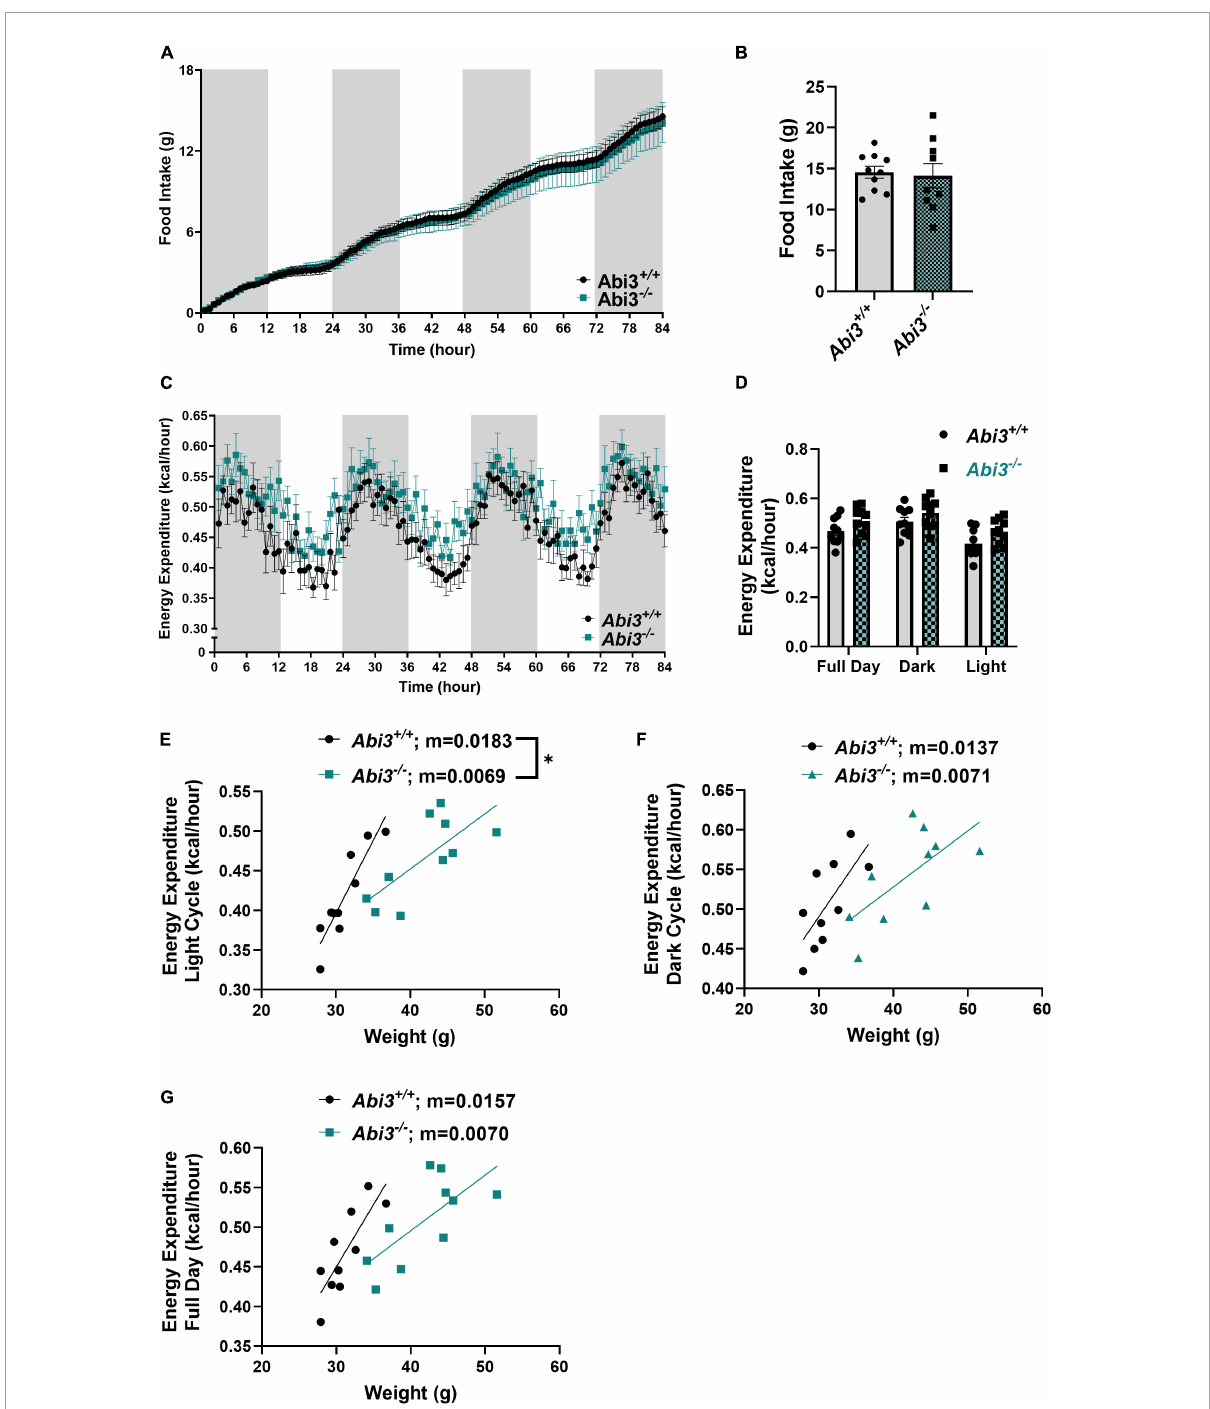
FIGURE2 Abi3 - / - mice exhibit impaired energy expenditure and unaltered food intake. 15-month-old male Abi3 + / + ( n = 10) and Abi3 - / - mice ( n = 10) were singly housed in metabolic cages and (A,B) food intake and (C,D) energy expenditure were recorded over 84 h. For time course graphs (A,C) , the shaded portions represent night hours (dark cycle) and the unshaded portions represent daytime (light cycle). (A) Food intake over time and (B) overall total food intake were recorded. (C) Energy expenditure over time and (D) average energy expenditure were measured. (D) Average energy expenditure was calculated for the daytime/light hours (light cycle), night/dark hours (dark cycle), and the entire 84 h (full day). (E–G) Subsequent linear regression analysis of average energy expenditure vs. weight was performed to assess the relationship between lean mass and energy expenditure. Regressions were performed for (E) light cycle, (F) dark cycle, and (G) full day. Data represent mean ± SEM. Unpaired t -test, simple linear regression; ∗ p <